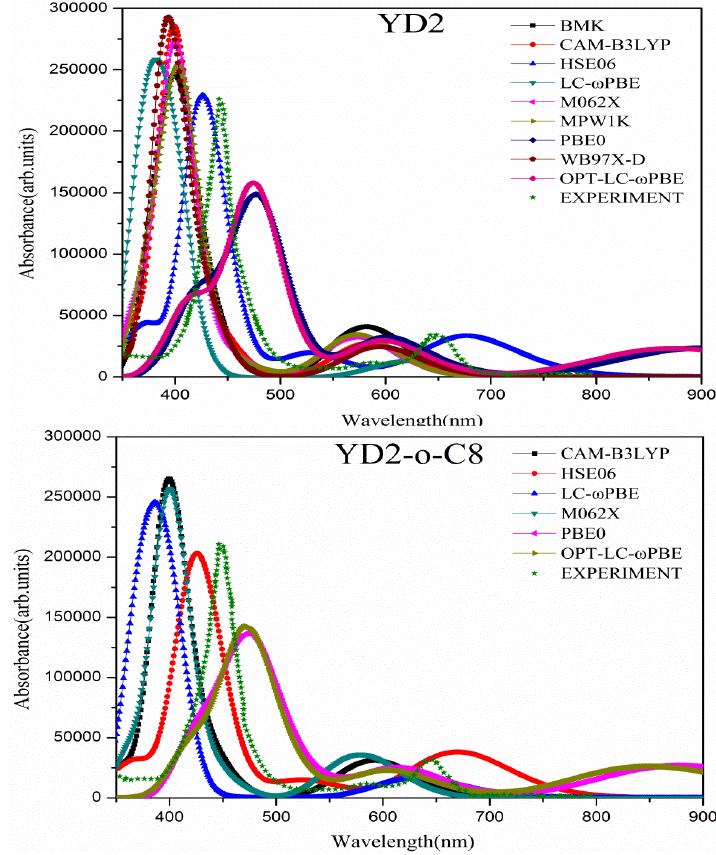
Figure 2. The simulated absorption spectra for YD2 and YD2-o-C8 dyes based upon TDDFT results calculated with different functionals. The experimental measured curves [46] are also